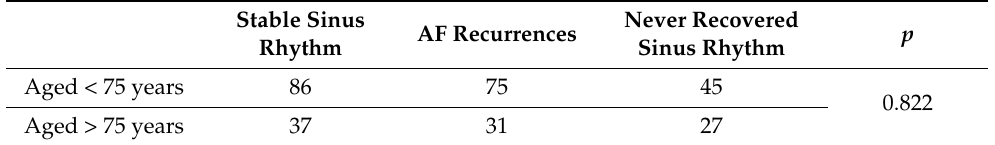
Table 4. Long-term results of AF